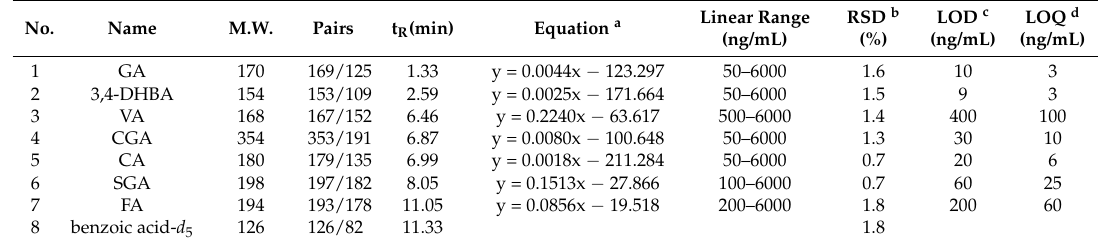
Table 5. Quantitative parameters for the standards ( 1 – 7 ) and internal standard ( 8